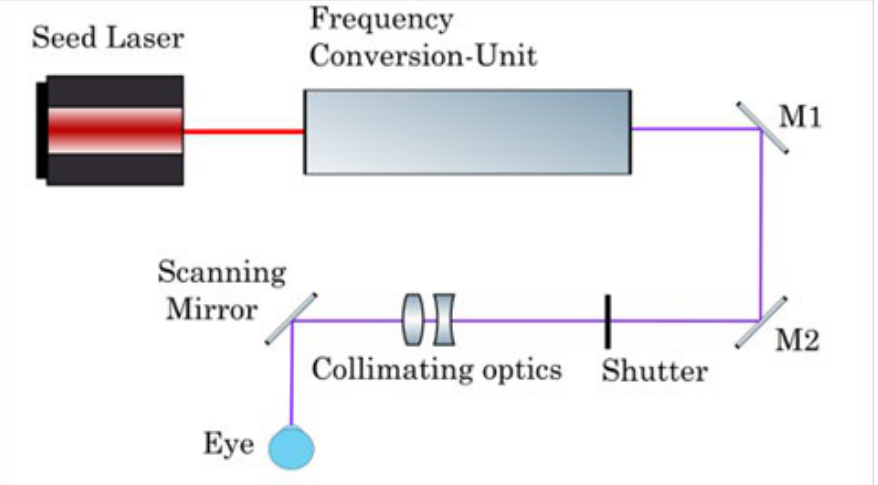
Figure 1. Scheme of the laser source and delivery system used in the AquariuZ system.